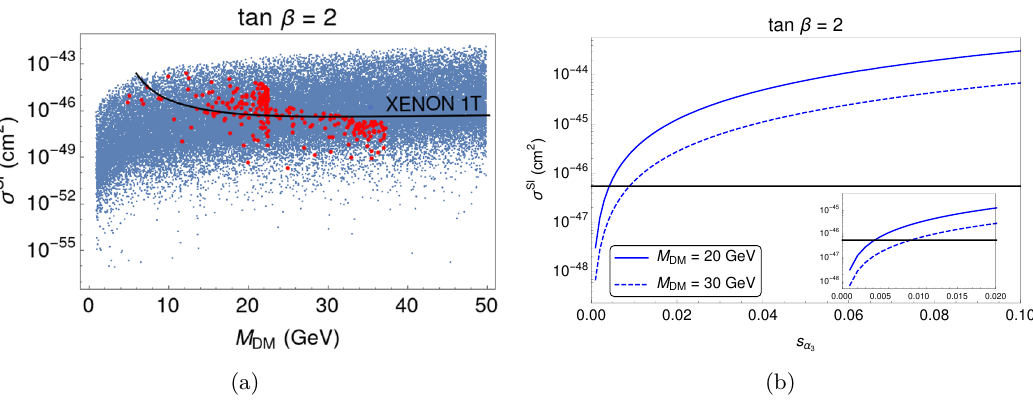
Figure 20 . (a) The bounds on M DM from relic and the allowed limit on DM direct detection cross section ( σ SI ). (b) The variation of σ SI with s α